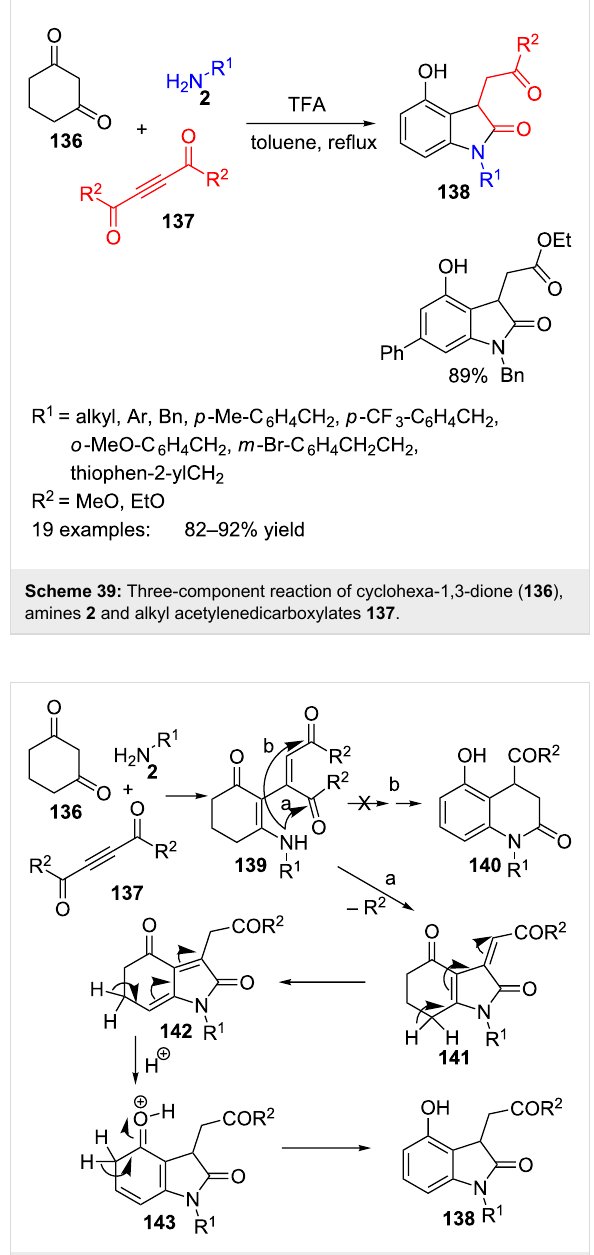
Scheme 40: Proposed mechanism for the formation of 2-oxindoles 138